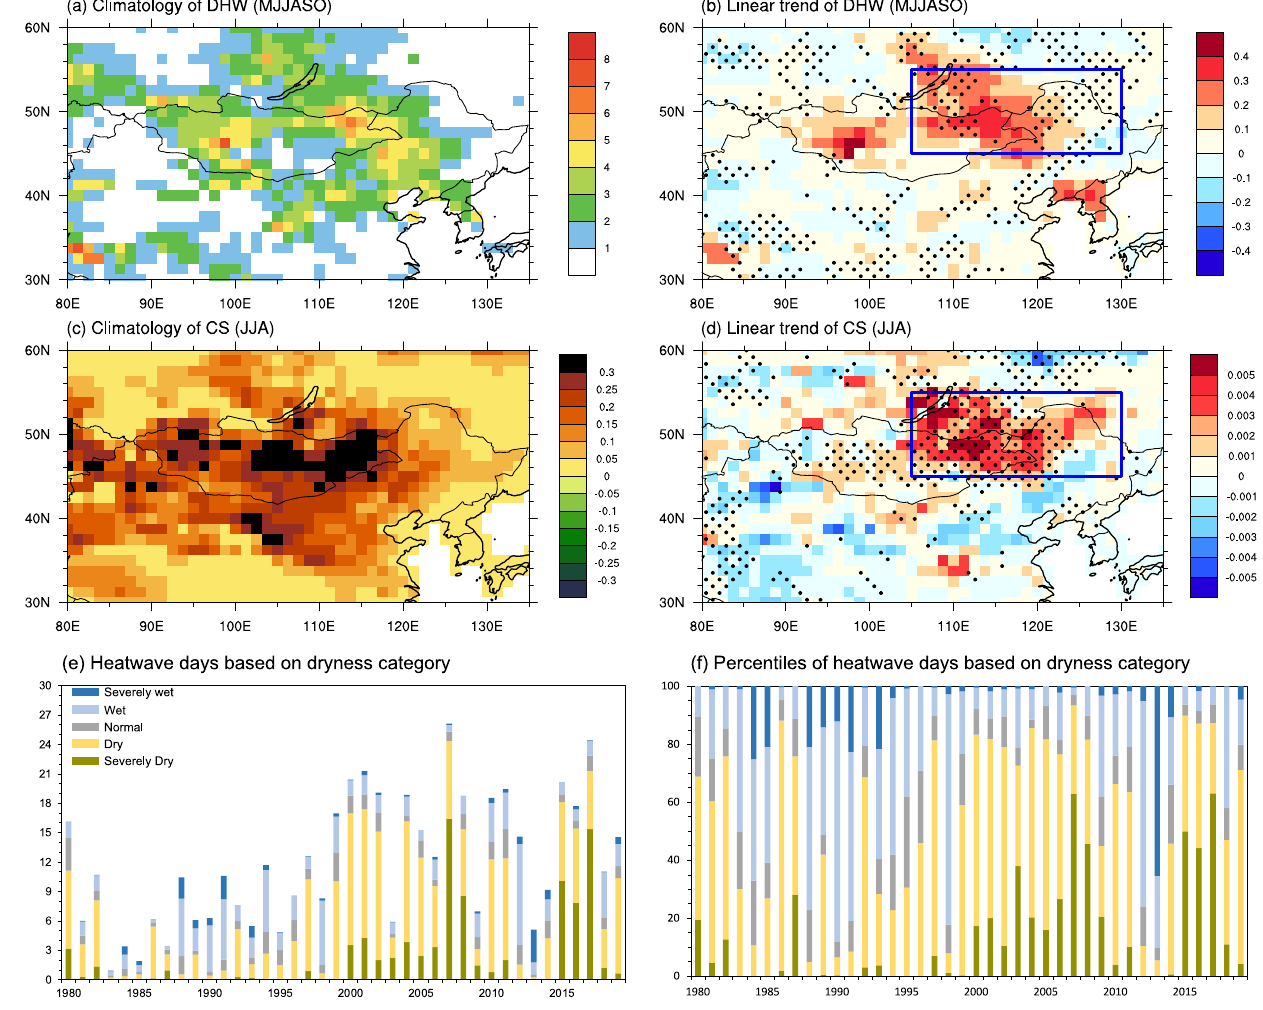
Fig. 1 Linear trends of DHW and CS, and time series of DHW based on dryness category. Climatology of ( a ) dry heatwave (DHW) during warm season (MJJASO) (days year − 1 ) and ( c ) soil moisture-temperature coupling strength index (CS) during summer (JJA) for the period 1980 – 2019 and ( b ), ( d ) their linear trends. The dots in ( b ) and ( d ) denote the 90% con fi dence level using the P value. Time series of ( e ) heatwave days based on dryness category and ( f ) its percentiles during the period 1980 – 2019 over Eats Asia [105 – 130°E, 45 – 55°N]. The dryness categories are distinguished based on scPDSI; severely dry (scPDSI < -3), dry ( − 3 < scPDSI < – 0.5), normal ( − 0.5 <scPDSI <0.5), wet (0.5 <scPDSI <3), and severely wet (scPDSI